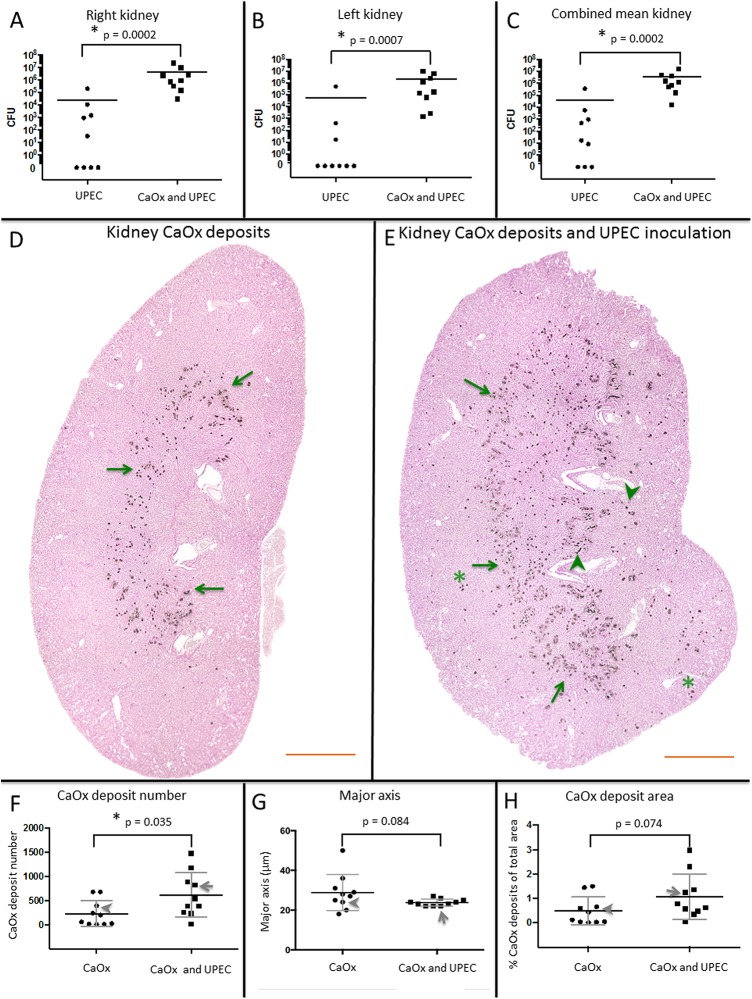
Bacteria increases the murine CaOx deposit burden.A. The mean right (A), left (B) and combined mean (C) kidney bacterial burdens were lower with UPEC inoculation alone compared to kidneys with CaOx deposits and UPEC inoculation at 56,157±1.68X105 versus 2.14X106±3.34X106; 24,843±69,527 versus 4.50X106±7.83X106 and 40,500±1.12X105 versus 5.28X106±1.78X106 respectively. To present on a log scale graph, but not during statistical analysis, 0 values were assigned a value of 0.01 (D). Following glyoxalate injection, CaOx deposits are seen around the corticomedullary junction (arrows) (E) Following UPEC inoculation and glyoxalate injection, an increased distribution and number of CaOx deposits (arrows) is noted, extending into the medulla (arrowheads). D-E, representative 4X magnification image stitches, background cropped for clarity, scale bar = 1000μm. (F) CaOx deposit number per mean 4X imaging stitch cross-section area was significantly higher in the CaOx deposits and UPEC inoculation group compared to kidney stones alone. There was a higher percentage of CaOx deposit/total kidney cross section area (H) with CaOx deposits and UPEC than CaOx deposits alone. The location on the scatterplot for the representative images (D) and (E) are indicated by an arrowhead and arrow respectively.